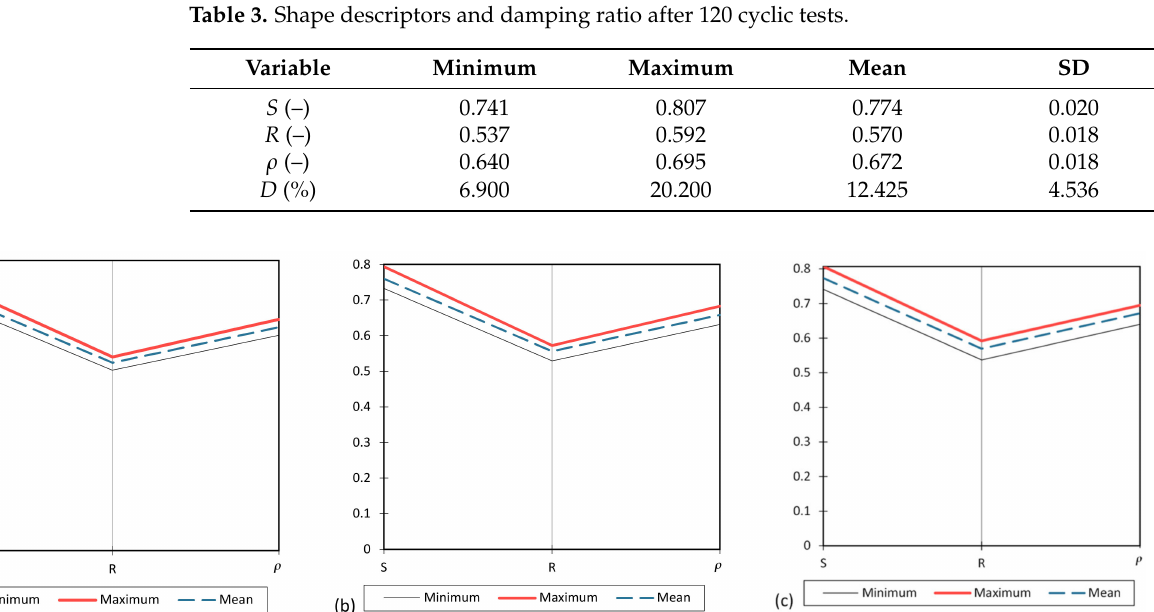
Figure 13. Variations of the three shape descriptors ( a ) before cycling, ( b ) after 30 cycles and ( c ) after 120 cycles. Note: S , R and ρ denote sphericity, roundness and regularity,